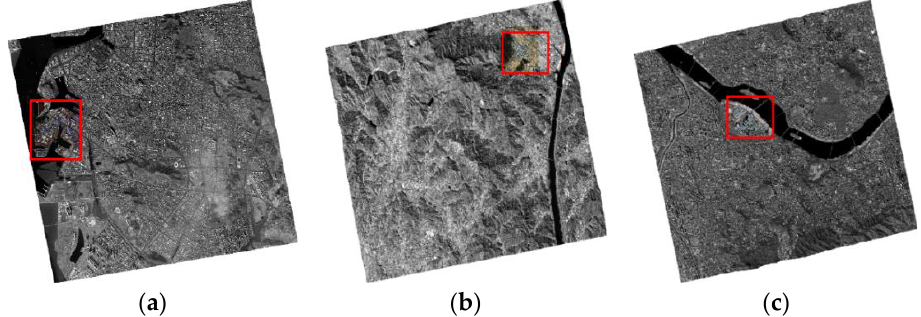
Figure 4. Study areas in Kompsat-3A images used. Red boxes indicate the areas for ( a ) Incheon, ( b ) Chilgok, and ( c ) Seoul.